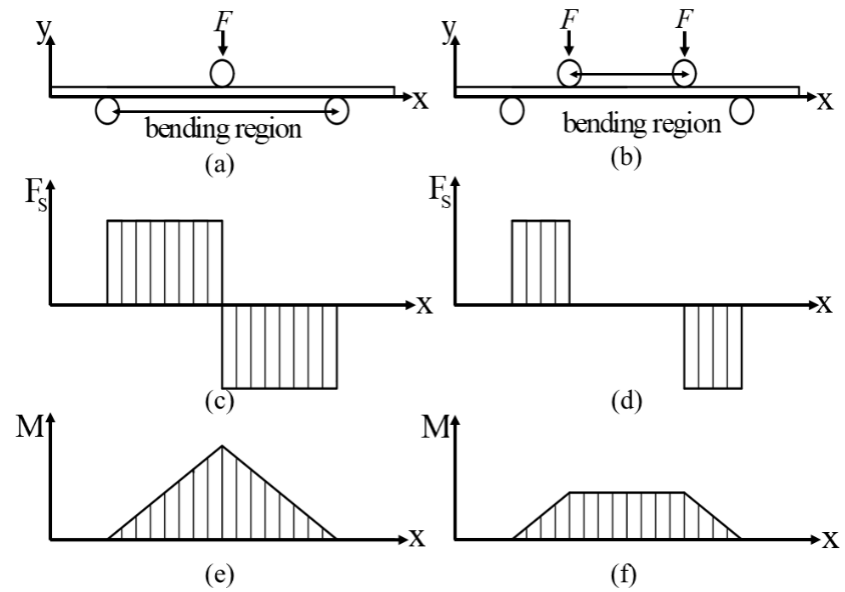
Figure 4. ( a ) Three-point bending diagram. ( b ) Four-point bending diagram. ( c ) Three-point bending shear force diagram. ( d ) Four-point bending shear force diagram. ( e ) Three-point bending moment diagram. ( f ) Four-point bending moment diagram.